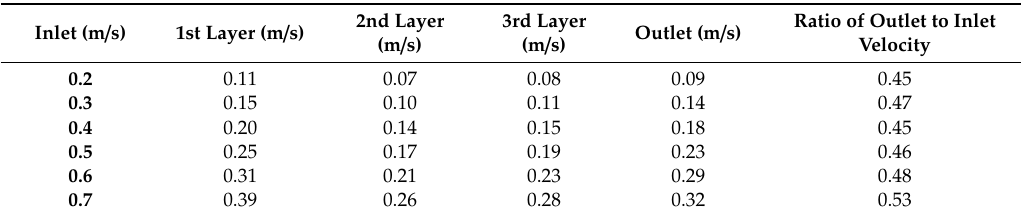
Table 2. CFD-simulated velocity changes for three layers of ba ffl es and outlet inside the hydraulic mixing basin with di ff erent inlet velocities.